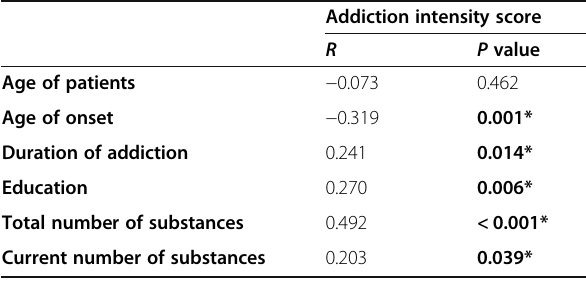
Table 5 Correlations between Addiction Intensity Scale (AIS) scoring and some clinical and addictive